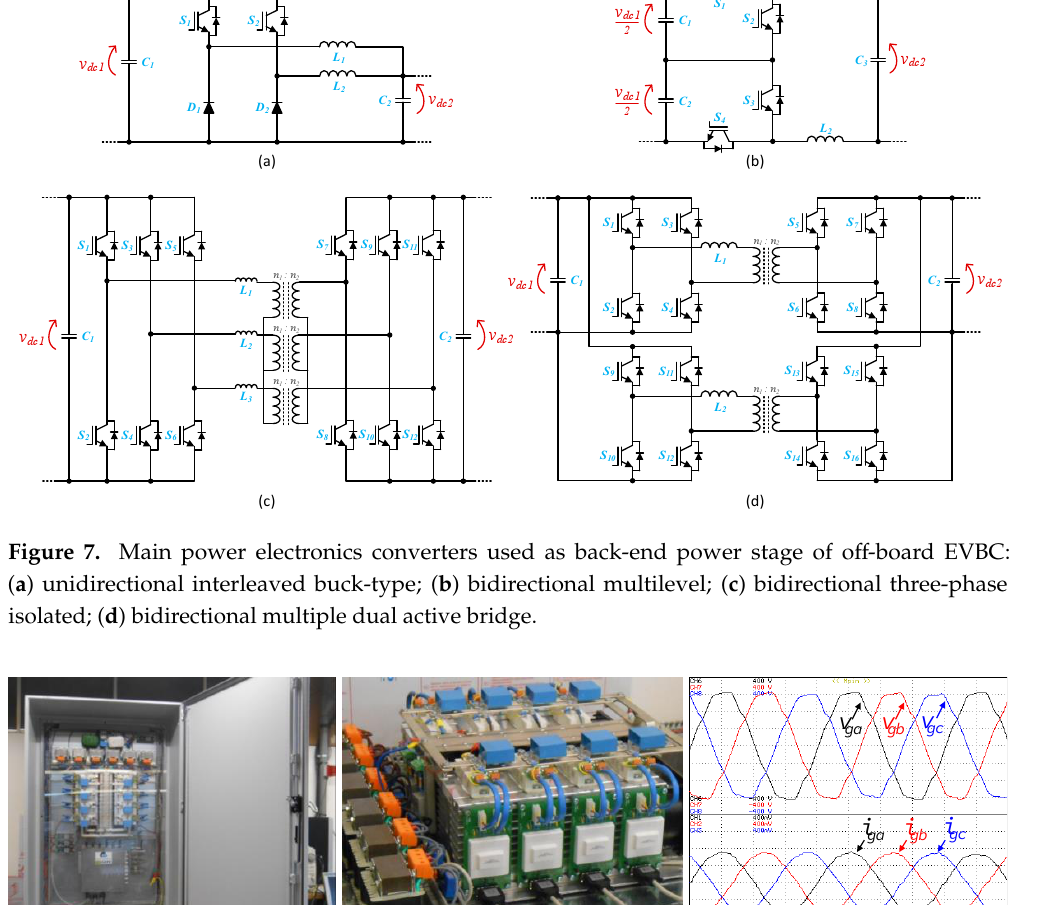
Figure 8. Off-board EVBC: ( a ) example of a developed laboratory prototype; ( b ) detail of the power electronics converters; ( c ) experimental results showing the voltages ( v ga , v gb , v gc : 100 V/div|5 ms/div) and the currents ( i ga , i gb , i gc : 10 A/div|5 ms/div) on the power grid side.